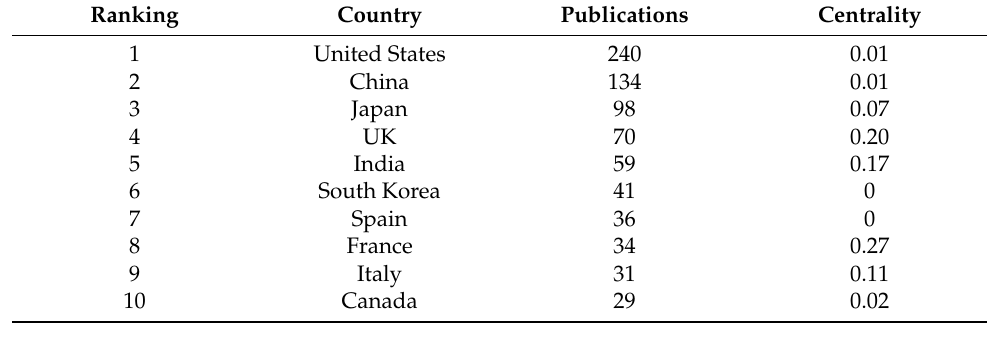
Table 3. Top 10 countries involved in EPW HMI methodology research.